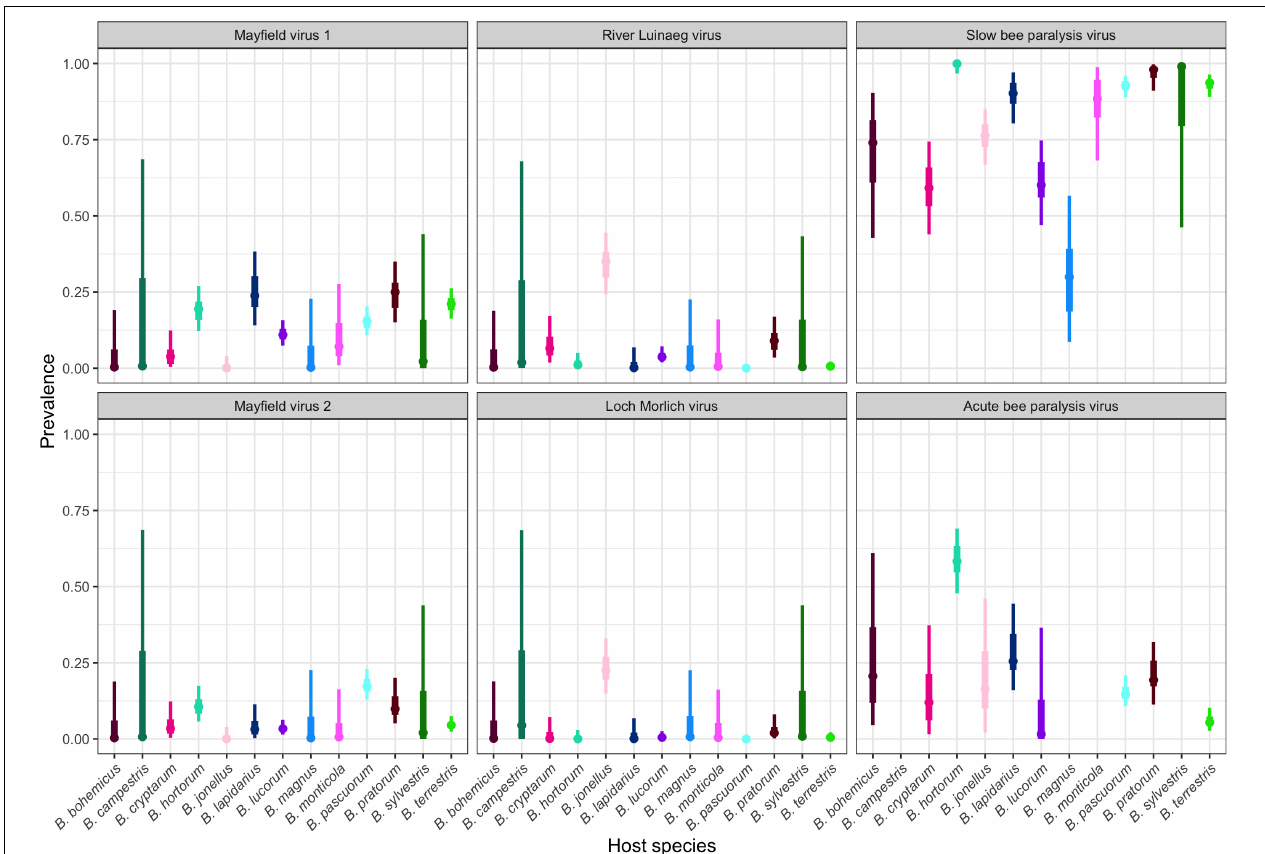
FIGURE 3 | The prevalence of Acute bee paralysis virus, Loch Morlich virus, Mayfield virus 1, Mayfield virus 2, River Luinaeg virus, and Slow bee paralysis virus in each sampled host species. The point estimate is the posterior mode, with 50% shortest posterior intervals represented by the thick lines and 90% shortest posterior intervals represented by the thin lines. Shortest posterior intervals are a continuous credible interval (measured on the scale of the parameter) that contains 90% of the posterior density, that is, an interval that has a 90% chance of containing the correct parameter value under the model, the data and the priors. Untested combinations are left blank. Species are colored by their corresponding color in Figure 1 for ease of reading.